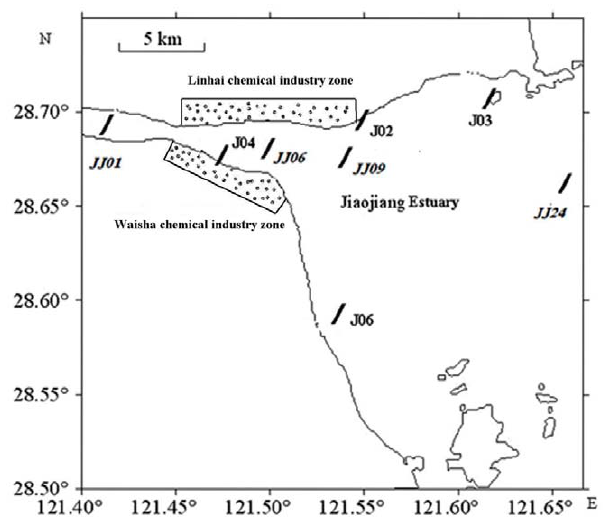
Figure 1. Map of the sampling sites within the Jiaojiang Estuary. The subtidal sediment sampling sites are indicated with italics.